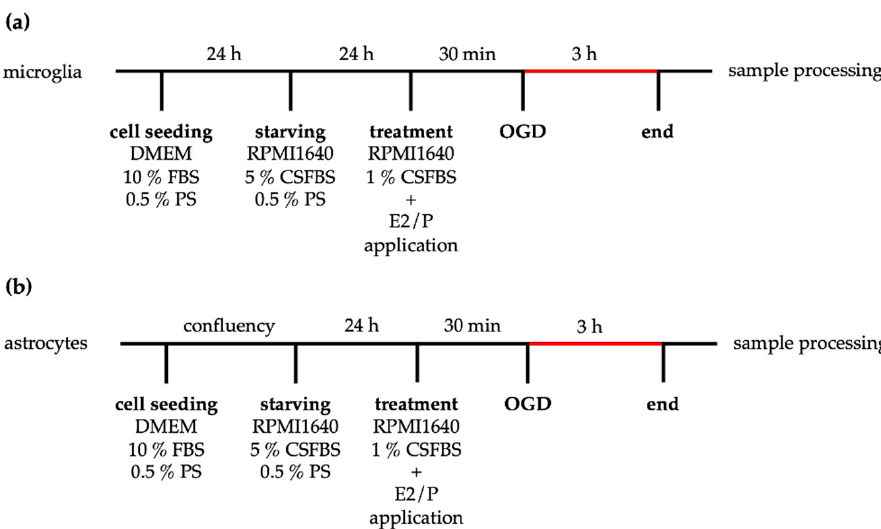
Figure 11. Scheme of the OGD experimental design. After isolation, microglia ( a ) or astrocytes ( b ) were seeded in the culture medium. Microglia were starved in RPMI 1640 5% CSFBS on the next day, whereas astrocytes ( b ) were maintained in the culture medium until the resulting monolayer stopped cell proliferation. Then, astrocytes were cultured with RPMI 1640 5% CSFBS for 24 h. Prior to OGD, cells received new RPMI1640 plus 1% CSFBS medium with or without E2 or P supplementation. After 3 h of OGD and the corresponding time under normoxic conditions, samples were further processed for analysis.